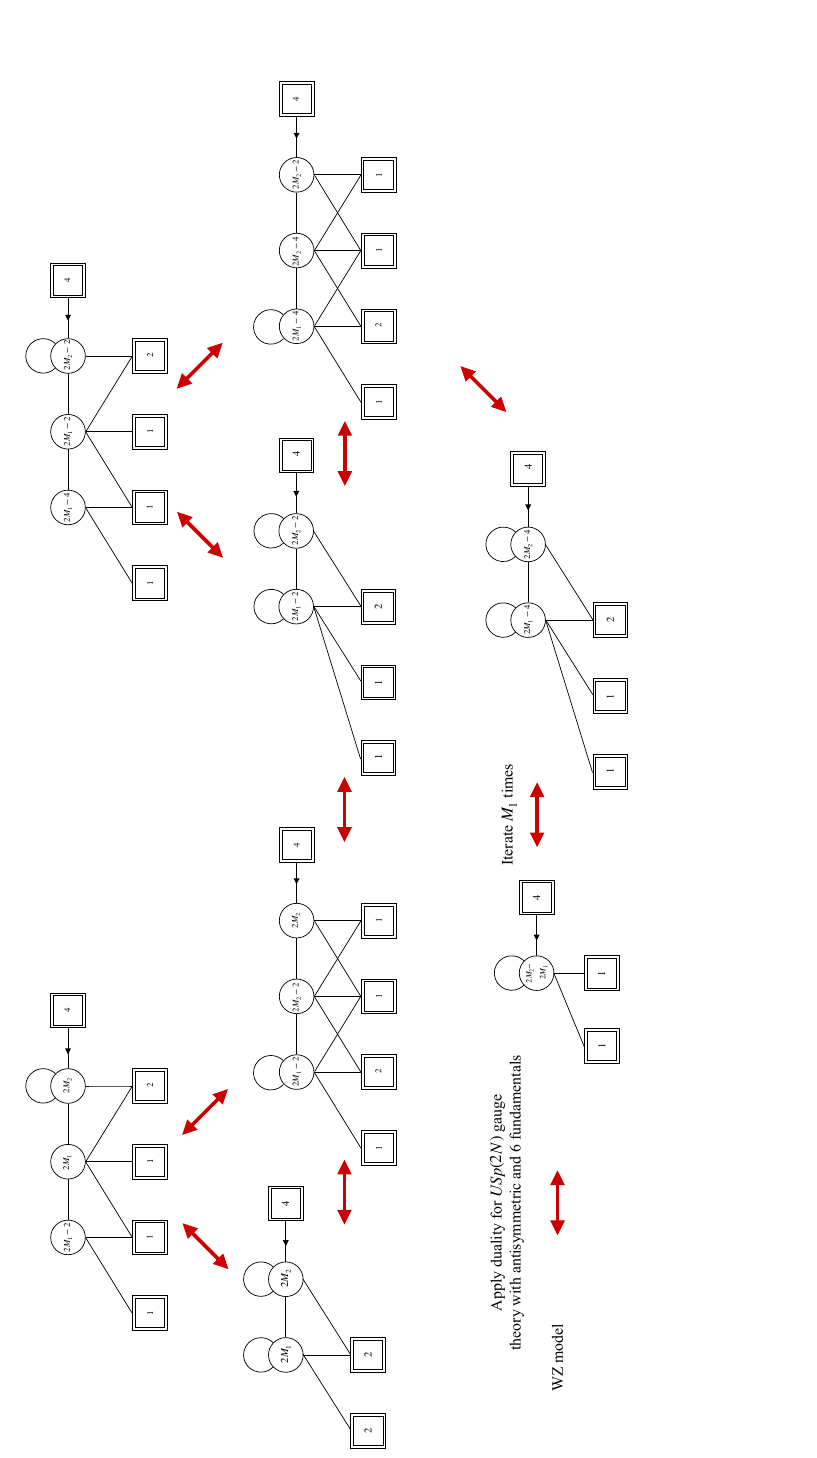
Figure 7 . Schematic representation of the main steps of the derivation of the duality for N = 2 . We avoid drawing singlets not to clutter the